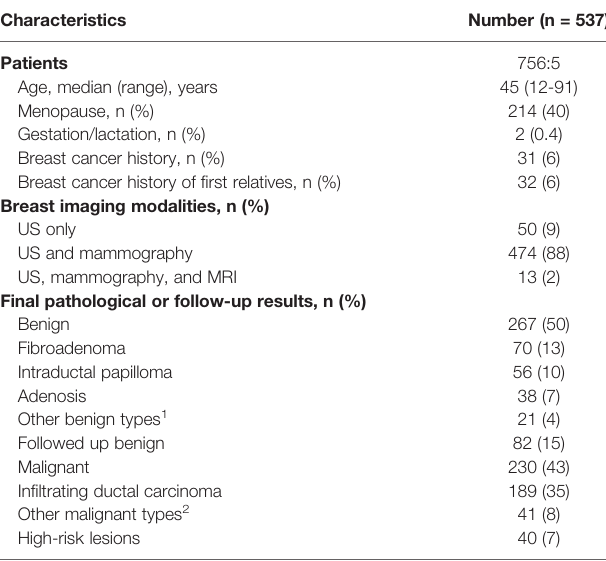
TABLE 1 | Basic information of enrolled